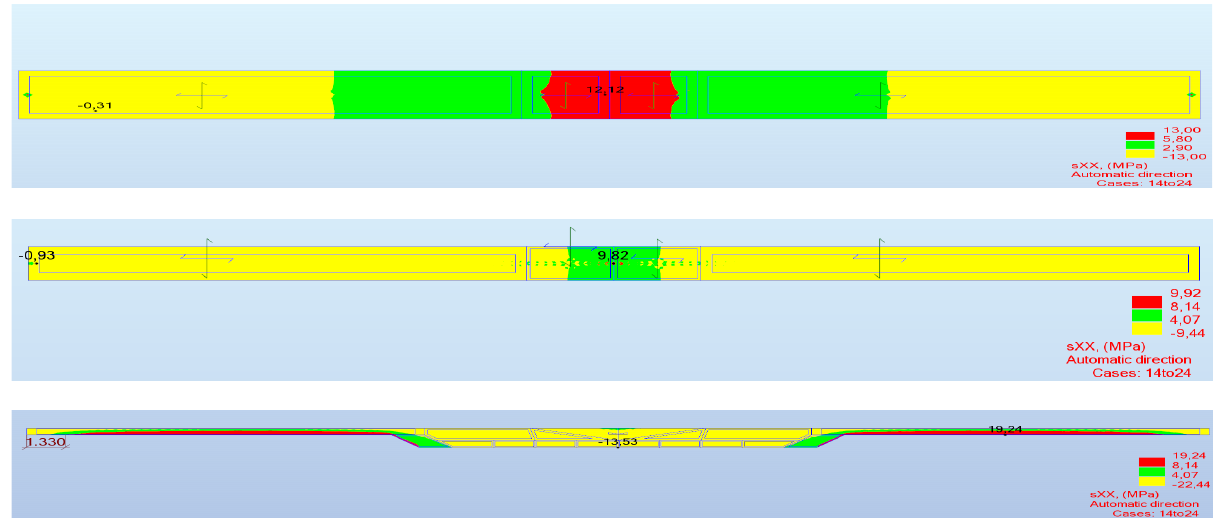
Figure 15: Tensile stress layout in in situ slab (top view), upper slab (top view) and concrete web of the prefab (side view) – uncracked analysis (step